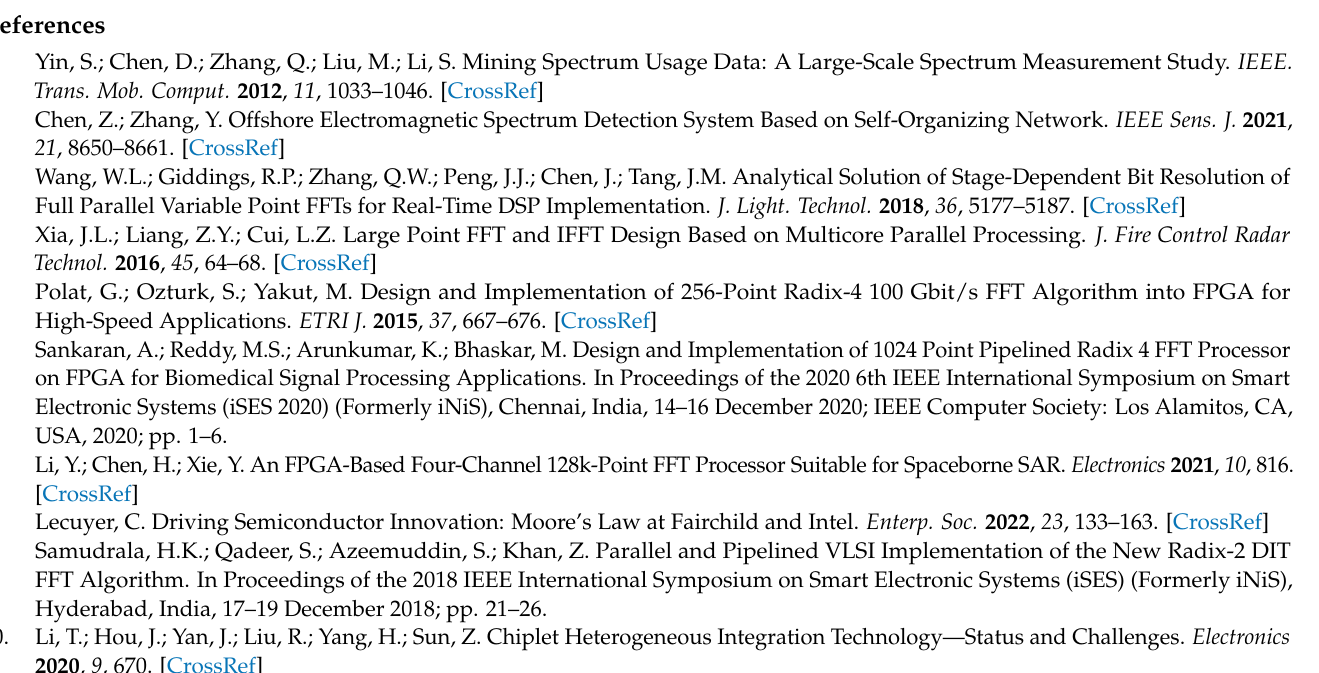
is 4900 MHz; and ( f ) extracted SNR when the frequency of the input signal is 4900